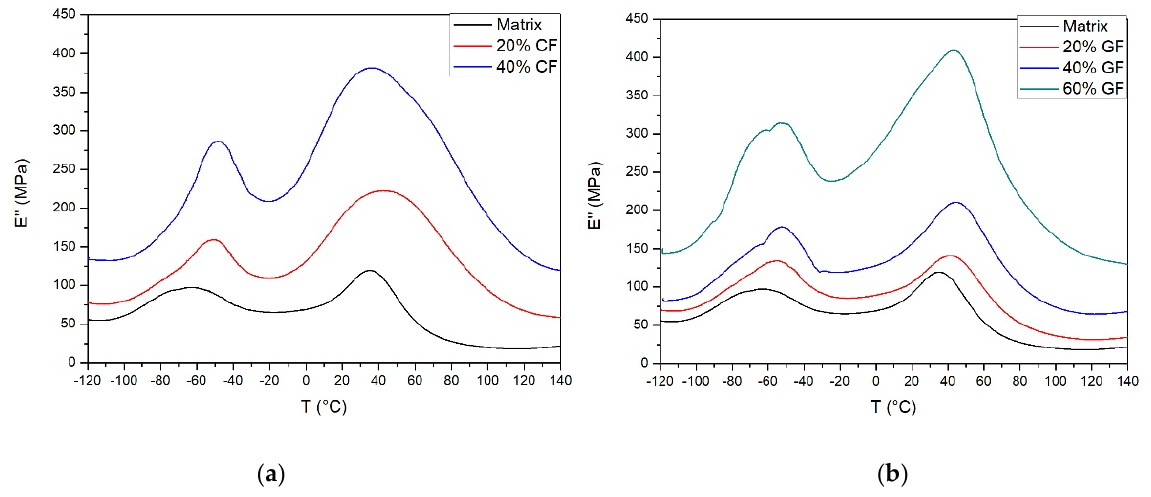
Figure 2. Loss modulus of ( a ) carbon fiber composites, ( b ) glass fiber composites.